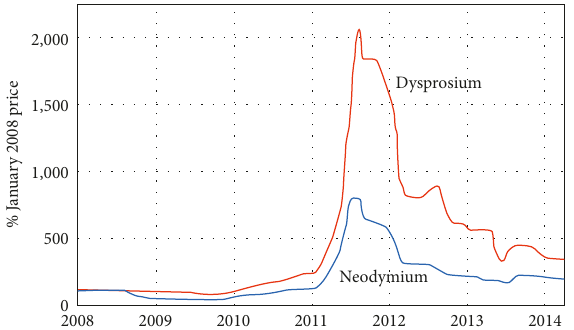
Figure 3: Price spike of RE metals experienced during the 2011–12 period as a result of controlled supplies